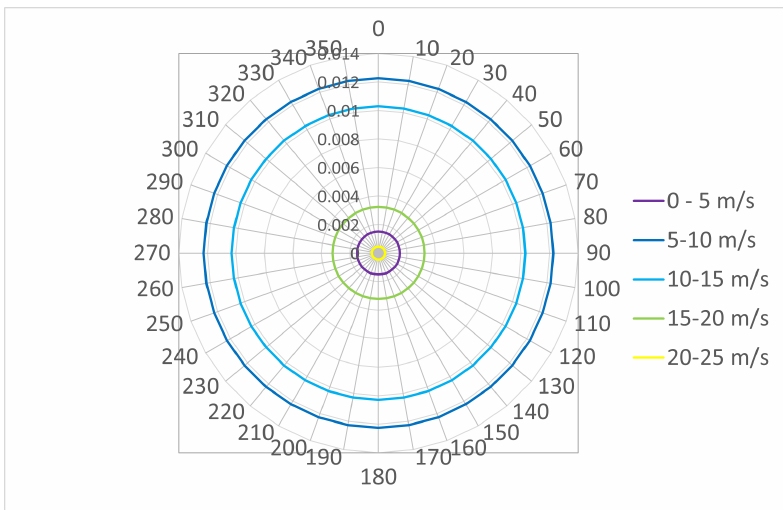
Figure A5. Wind Rose A –An equally distributed wind rose.